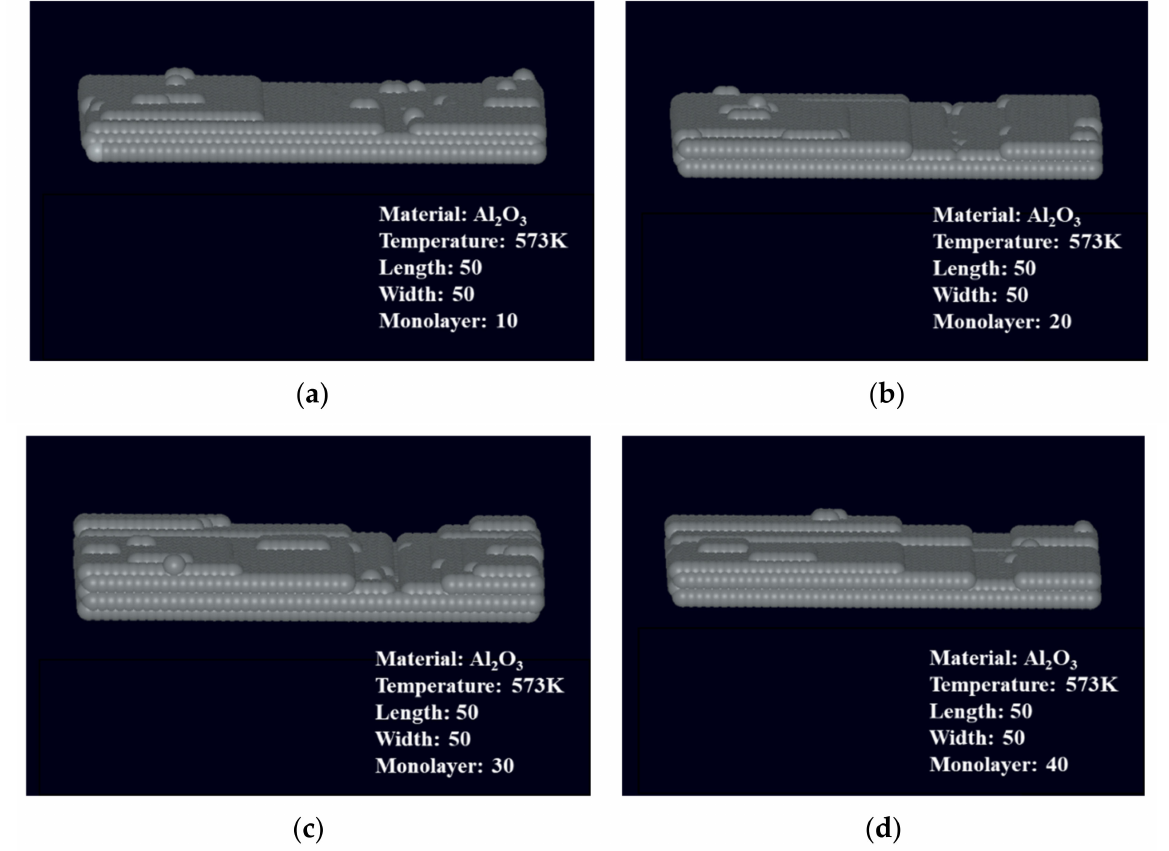
Figure 1. The simulation results for Al 2 O 3 film growth via ALD based on Monte Carlo simulation. ( a ) 10 cycles. ( b ) 20 cycles. ( c ) 30 cycles. ( d ) 40